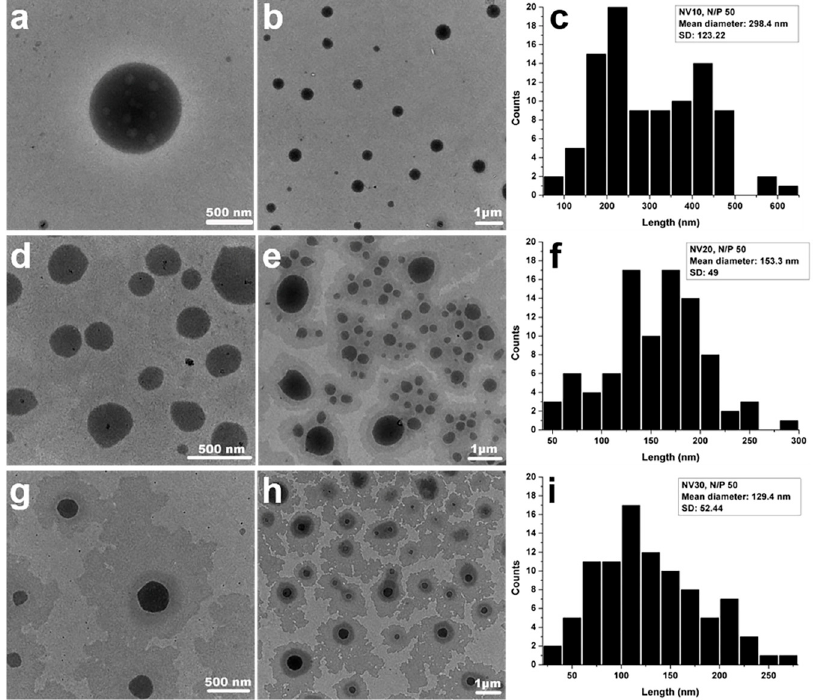
Figure 2. TEM micrographs of NV10 ( a , b ), NV20 ( d , e ), NV30 ( g , h ); and corresponding average size distributions in water for: NV10 ( c ), NV20 ( f ) and NV30 ( i ). For the size distribution path 90 particles were measured.